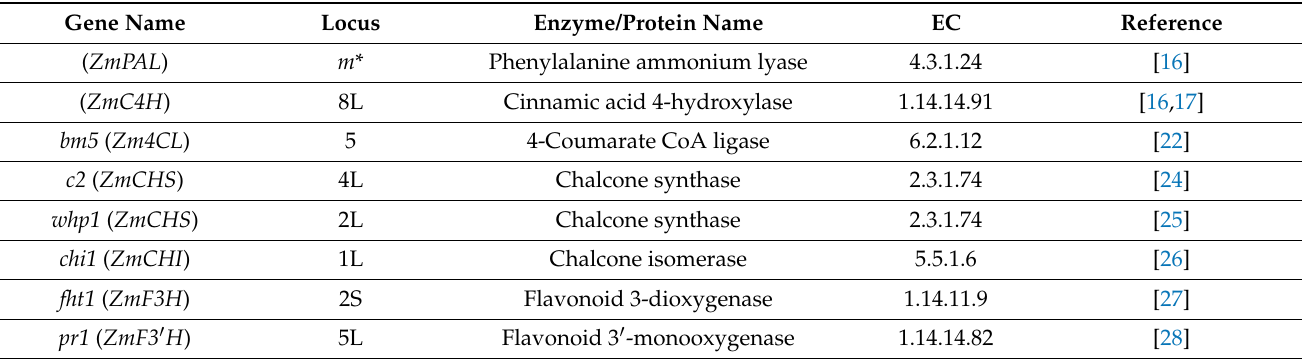
Table 1. Summary of genes involved in the early steps of the maize flavonoid pathway.